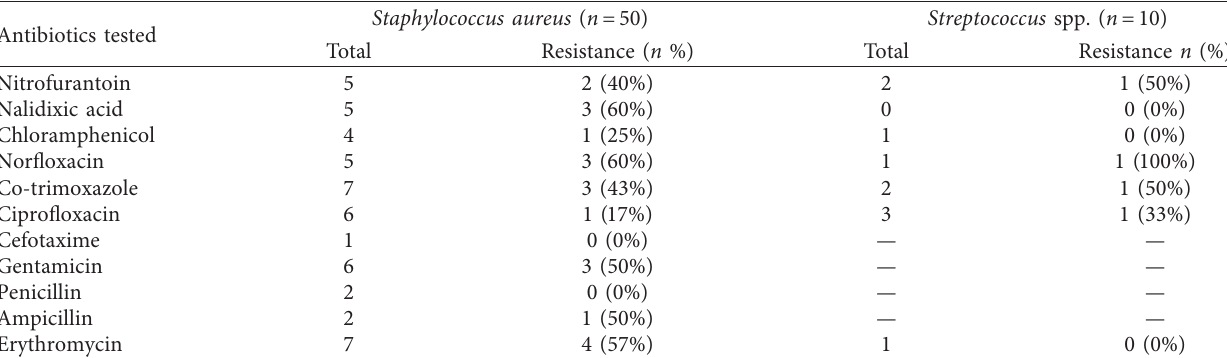
Figure 2: Resistance to antibiotics among pregnant women at LMUTH. Table 2: Susceptibility patterns of Staphylococcus aureus